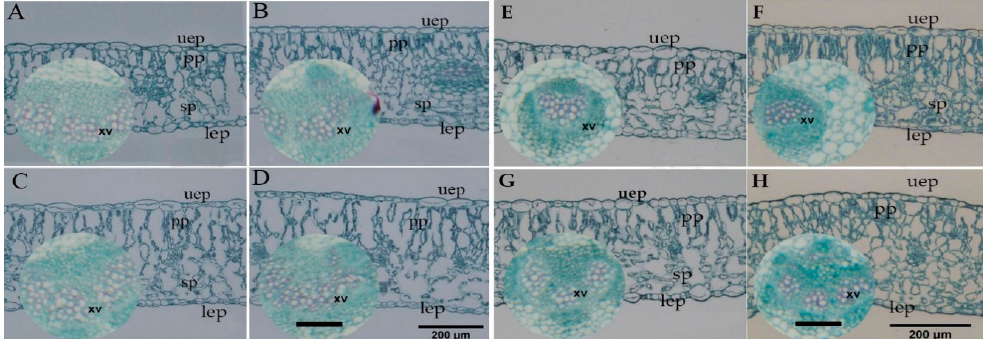
Figure 9. Transections of two rapeseed leaf blade affected by the application of melatonin and NaCl stress at flowering stage. ( A – D ): Yangyoushuang2, ( E – H ): Xiangyouza553. ( A , E ): non-NaCl stress + 0 µM melatonin (control). ( B , F ): NaCl-stress + 0 µM melatonin. ( C , G ): non-NaCl stress + 50 µM melatonin. ( D , H ): NaCl stress + 50 µ M melatonin. Uep: upper epidermis, pp: plastid